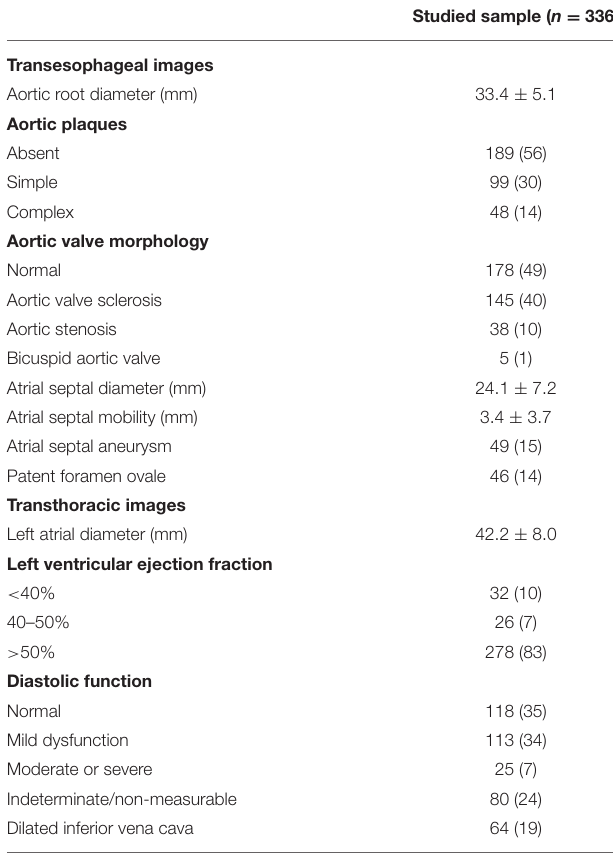
TABLE 1 | Transesophageal echocardiographic measurements and findings of patients with clinically indicated